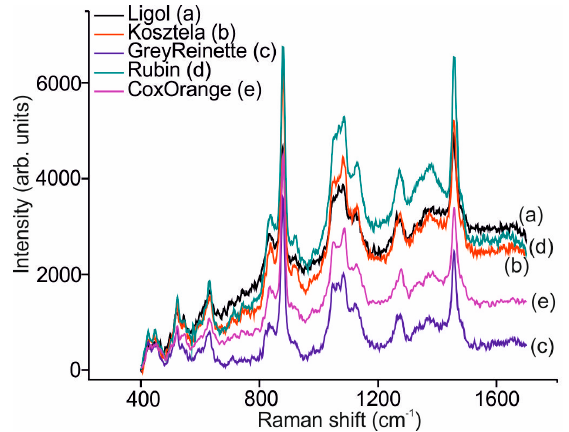
Figure 3. Raman spectrum of liqueurs made with different varieties of apple.